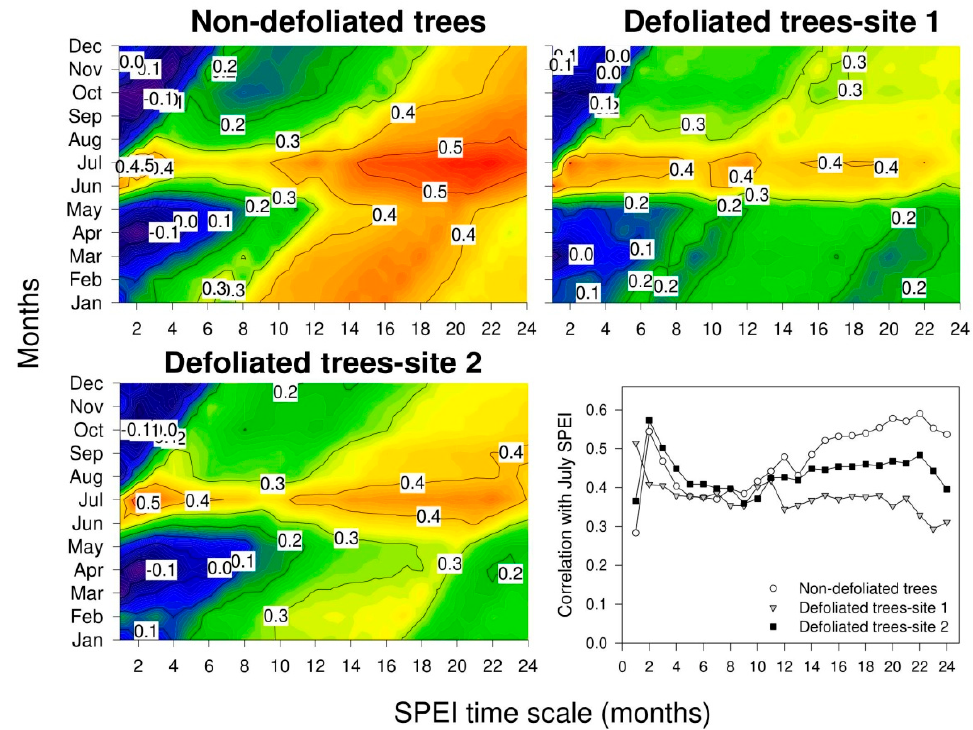
Figure 6. Drought–growth relationships based on the Pearson correlations calculated between mean series of ring-width indices of the three spruce stands and monthly SPEI data. The SPEI was calculated for 1- to 24-month scales (x axes) and from January to December (y axes). The line scatter plot shows the correlation with the July SPEI. Correlation coefficients ( r ) were calculated for the period 1950–2016 and they were significant at the 0.05 and 0.01 levels for r > 0.22 and r > 0.36, re- spectively.